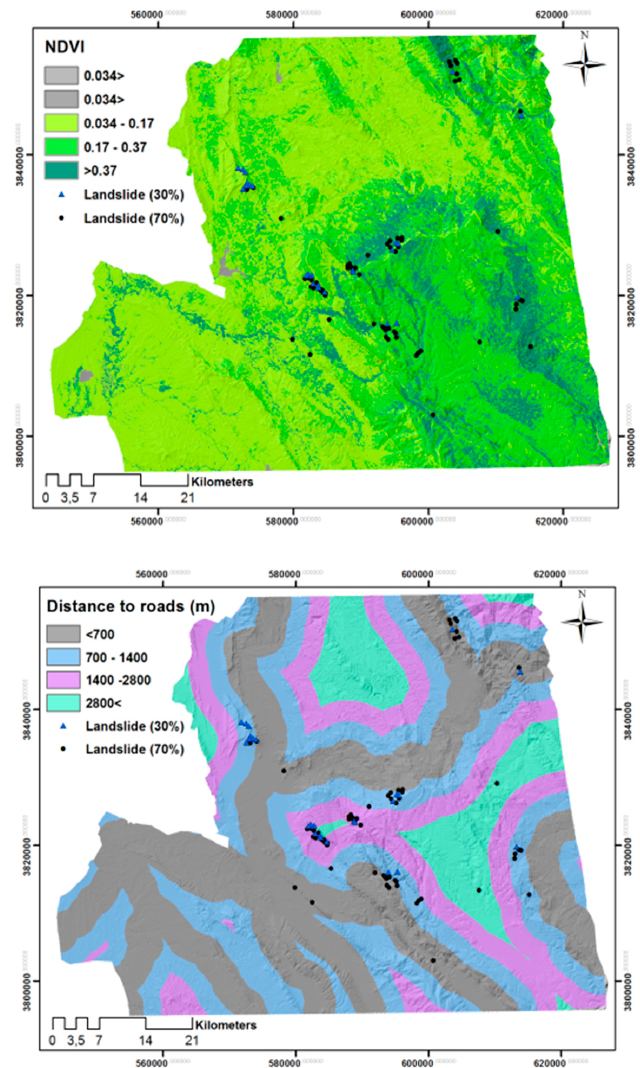
Figure 7. The representation of landslide conditioning factors of rainfall (mm/yr), distance to rivers (m), land cover, NDVI, and distance to roads.